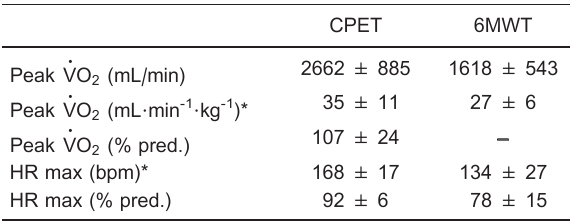
: VO 2 in the 6MWT corresponded to 78±13% of that in CPET, and the maximum heart rate in the 6MWT corresponded to 80±23% of that obtained in CPET. The